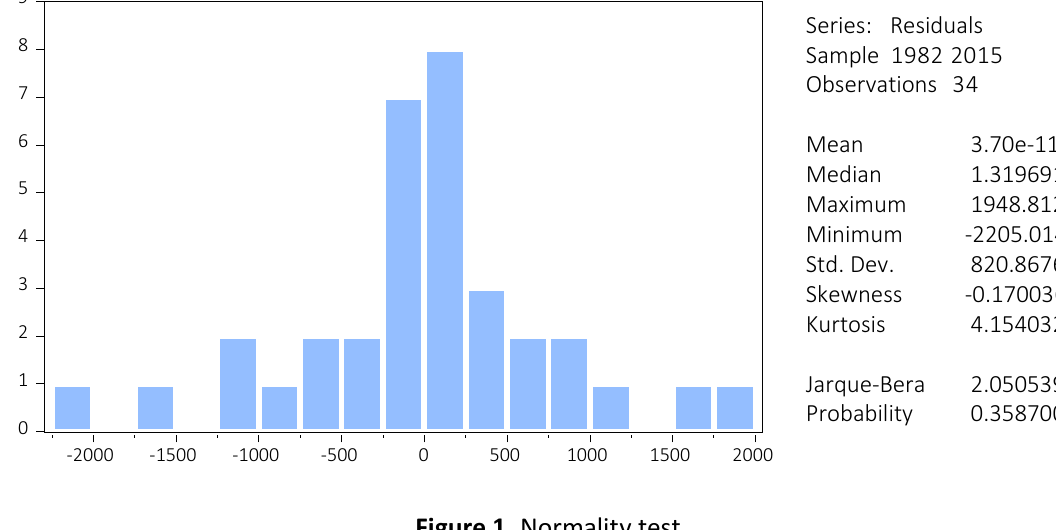
Figure 1. Normality